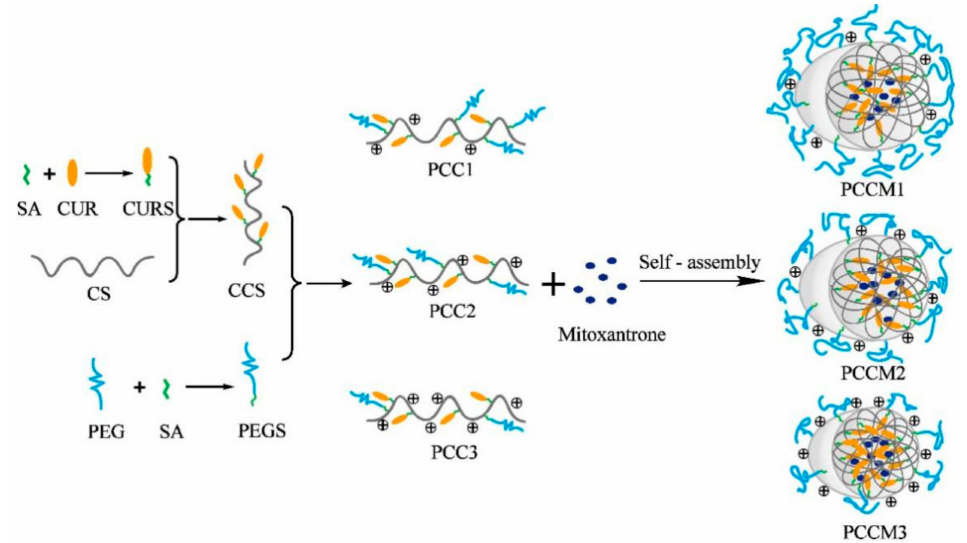
Figure 5. Schematic diagram illustrated the design and self-assembly of PCCM NPs with different density of PEG in each of